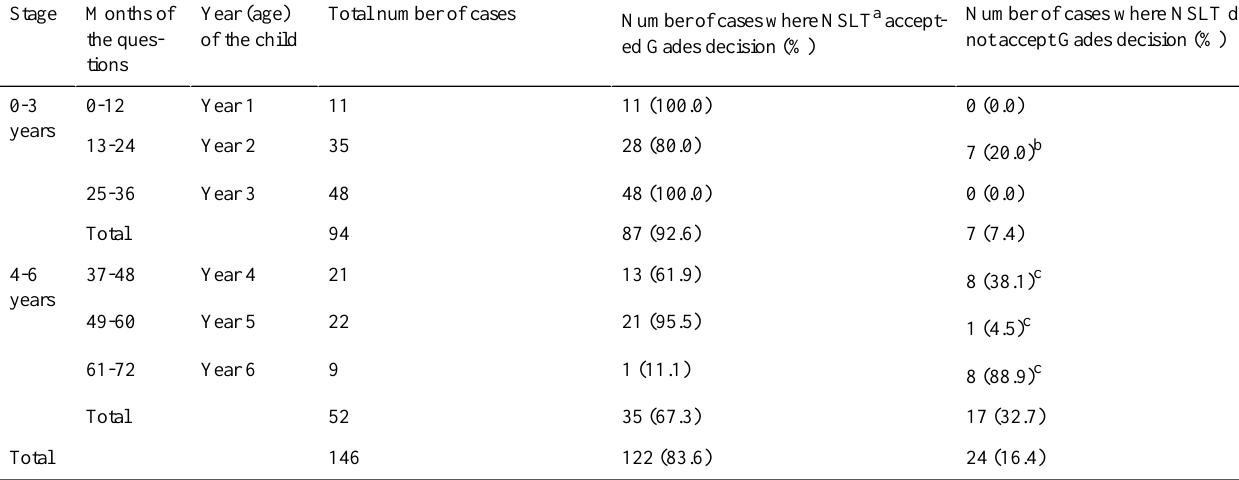
Table 2. Number of language evaluations performed and therapist decisions.